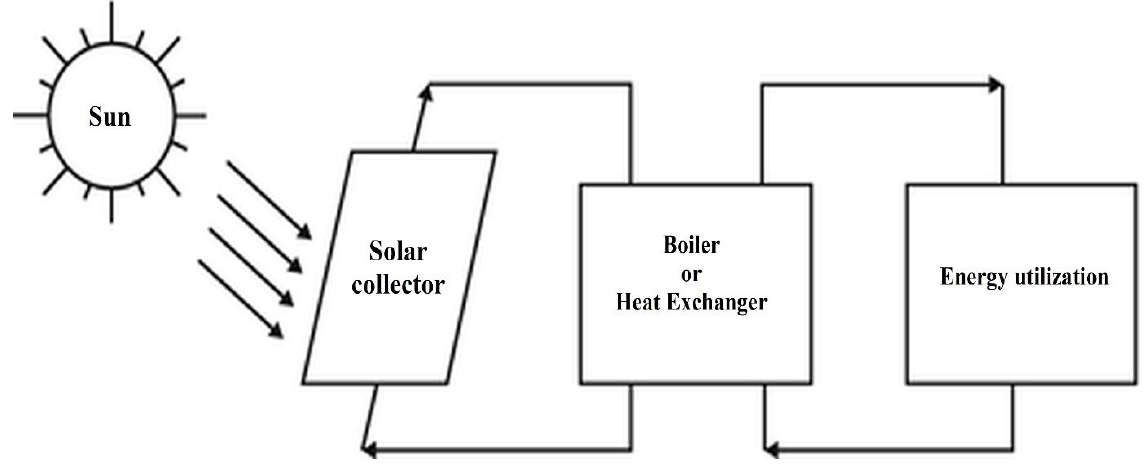
Figure 3. Systems to convert sunlight to